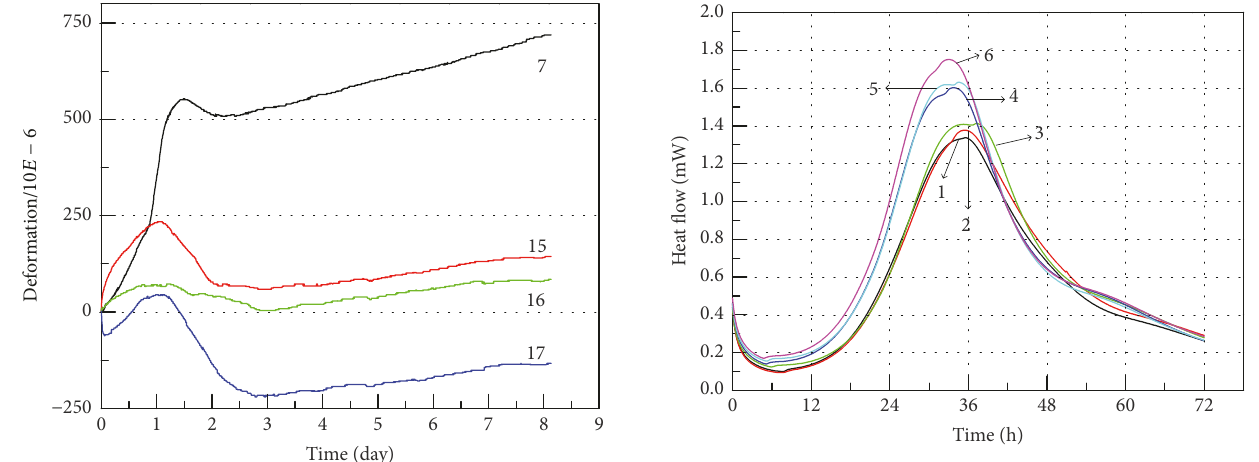
Figure 14: Heat flow versus time of references with